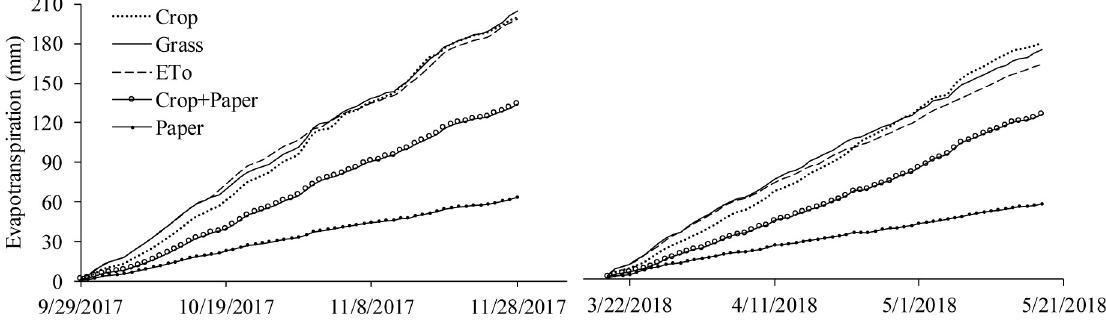
Fig 3. Evolution of water consumption in the drainage lysimeters with Bahia grass (Grass), recycled paper (Paper), Italian zucchini cultivated conventionally (Crop) and with mulch (Crop+Paper) and the reference evapotranspiration estimated by the Penman- Monteith method (ETo) for the two cultivation cycles. Vic¸osa-MG, DEA-UFV, 2017–2018.